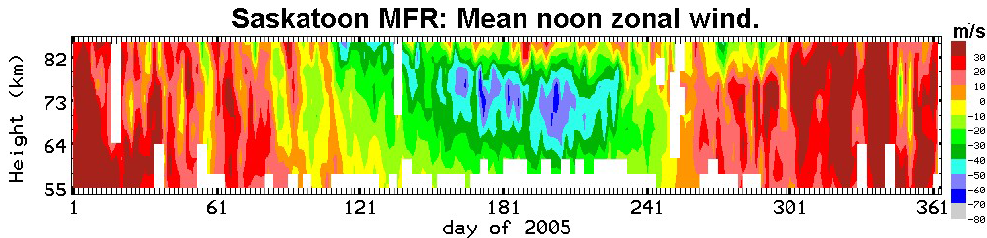
Fig. 2. Daily noon zonal wind at Saskatoon.